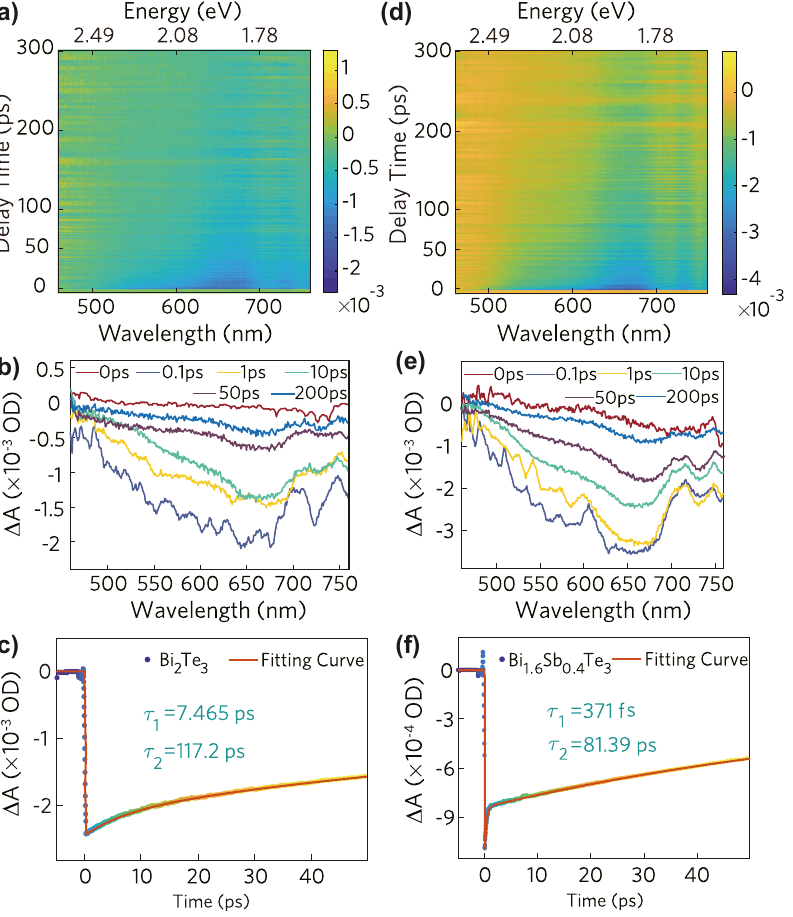
Te and Bi Sb Te . 2 3 1.6 0.4 3 Sb Te 1.6 0.4 3